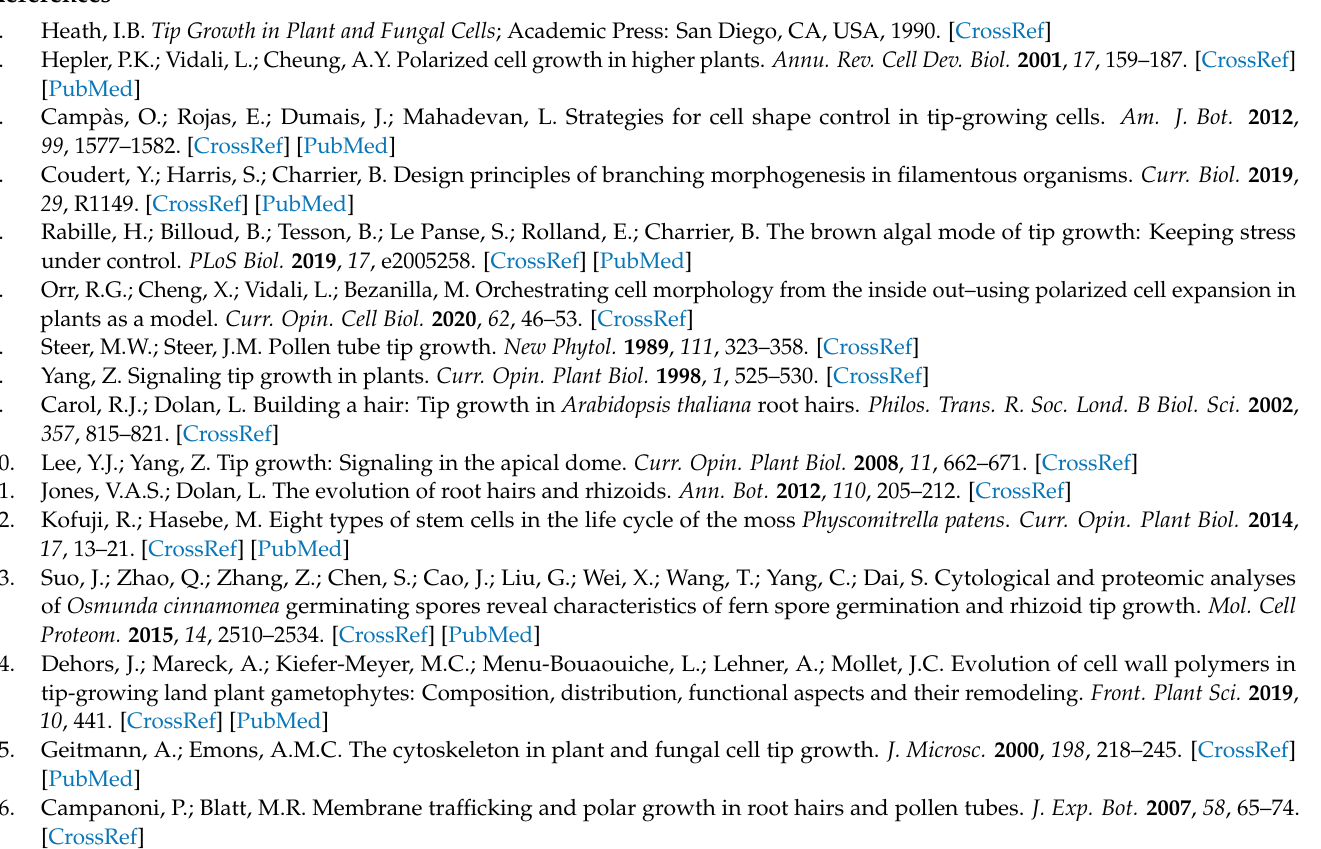
Figure S2. Reversal of the inhibitory effects of PEO-IAA by exogenous treatment with 2,4-D or NAA. Figure S3. Effects of treatment with the auxin antagonists 4-Cl-PEO-IAA and BH-IAA on the production of side branches in single-celled